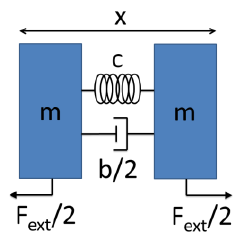
Figure 3. Simplified electromechanical model of a Langevin